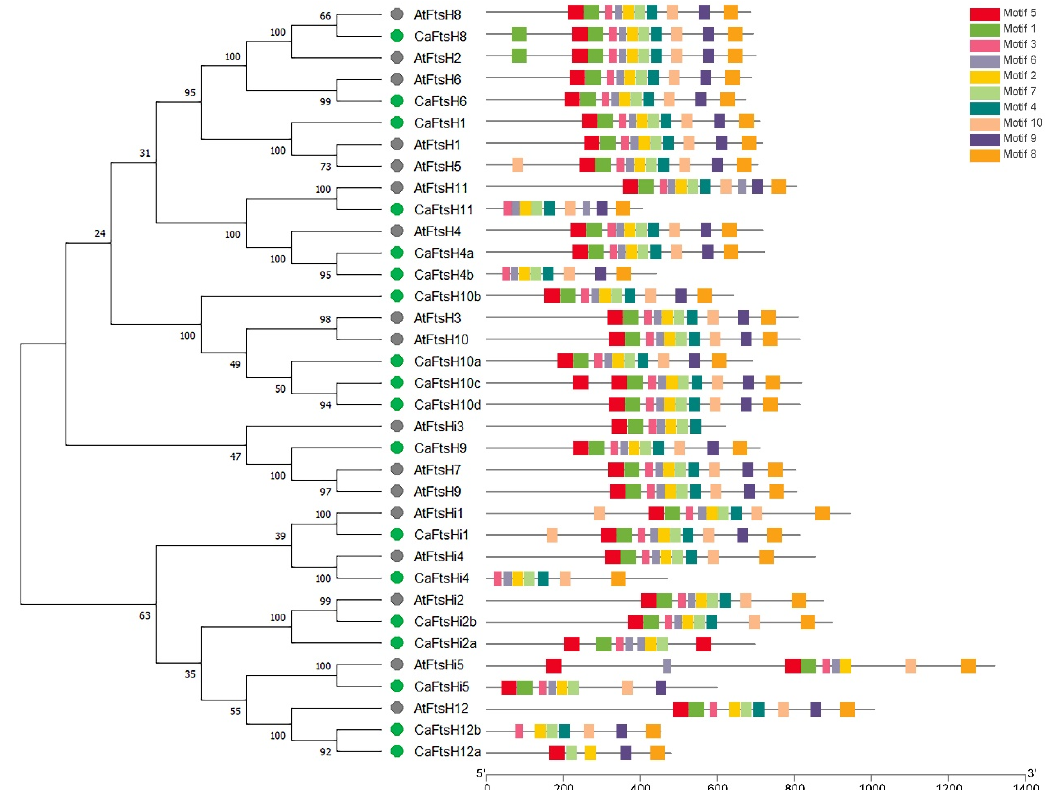
Figure 2. Phylogenetic relationships and conserved motif distributions of FtsH proteins in pepper and Arabidopsis. The phylogenetic tree was constructed based on the complete alignment of 35 FtsH proteins using the maximum-likelihood method. The proteins of pepper and Arabidopsis are distinguished by green and gray circles, respectively. The numbers beside the branches indicate the bootstrap support values by percentage that were obtained using 1000 iterations.